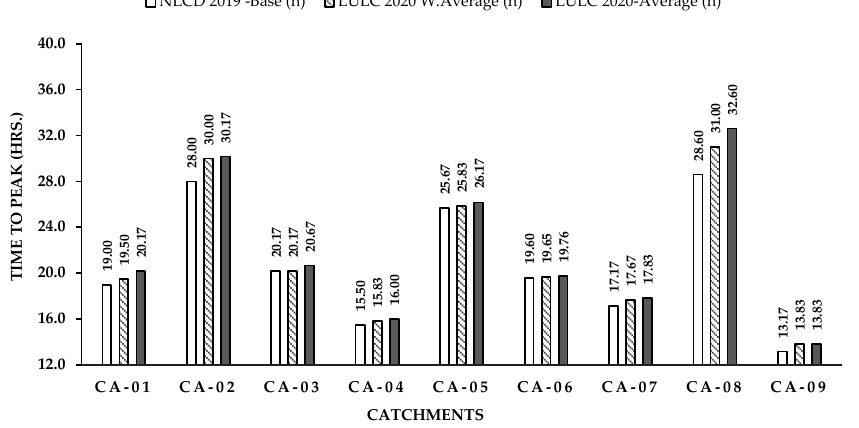
Figure 14. Time to peak flow in hours using LULC 2020-ESRI with ( n avg ) and ( n w.avg ), compared to base map calibration results.